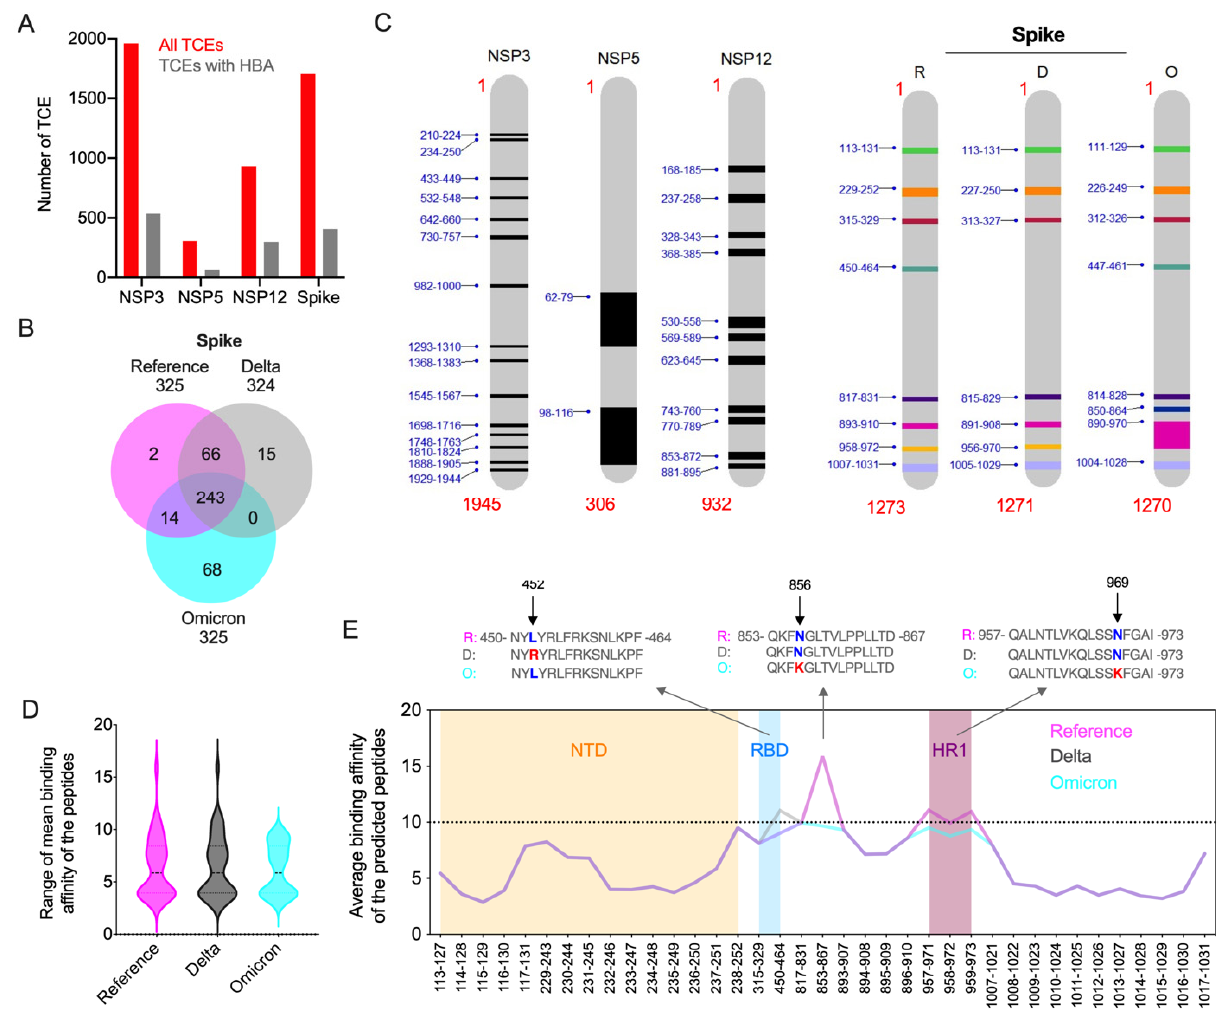
Figure 4. Prediction of high binding affinity CD4 TCEs of SARS-CoV-2 variants. ( A ) Overall distribution of HBA T-cell epitopes predicted from all nsp3, nsp5, nsp12, and spike proteins of three SARS-CoV-2 variants: reference, Delta, and Omicron. For each protein, the total number of predicted unique peptides (red) and the number of these peptides identified with HBA (grey) to at-least one prevalent global HLA allele is shown. ( B ) Comparison of high binding affinity TCEs from reference, Delta, and Omicron spike proteins. ( C ) The average binding affinity was calculated from the binding affinity score of each predicted fifteen amino acids peptides from four proteins with six prevalent HLA types studied. The functional hotspots in conserved nsp3, nsp5, and nsp12 proteins and spike are highlighted. Functional hotspots in spike predicted from reference (R) and two variants (D, Delta; O, Omicron) are shown. ( D ) The range and density of the median average binding affinity scores of the peptides predicted from the spike of the reference and two VOCs. For the comparison, the corresponding mean HBA TCEs in the reference and two variants (HBA score IC <= 10 nM or more in some peptides) are included. ( E ) The expanded version of panel D. The mean binding affinity score of each predicted peptide from the spike of three variants are plotted. Peptide coordinates provided in the X -axis are based on their locus in the reference protein. Mean HBA TCEs identified in NTD domain (orange), RBD domain (blue), and HR1 domain (plum) are highlighted. The key mutations that alter the binding affinity of the TCEs of Omicron and Delta variants are shown in the alignment of the predicted peptides.